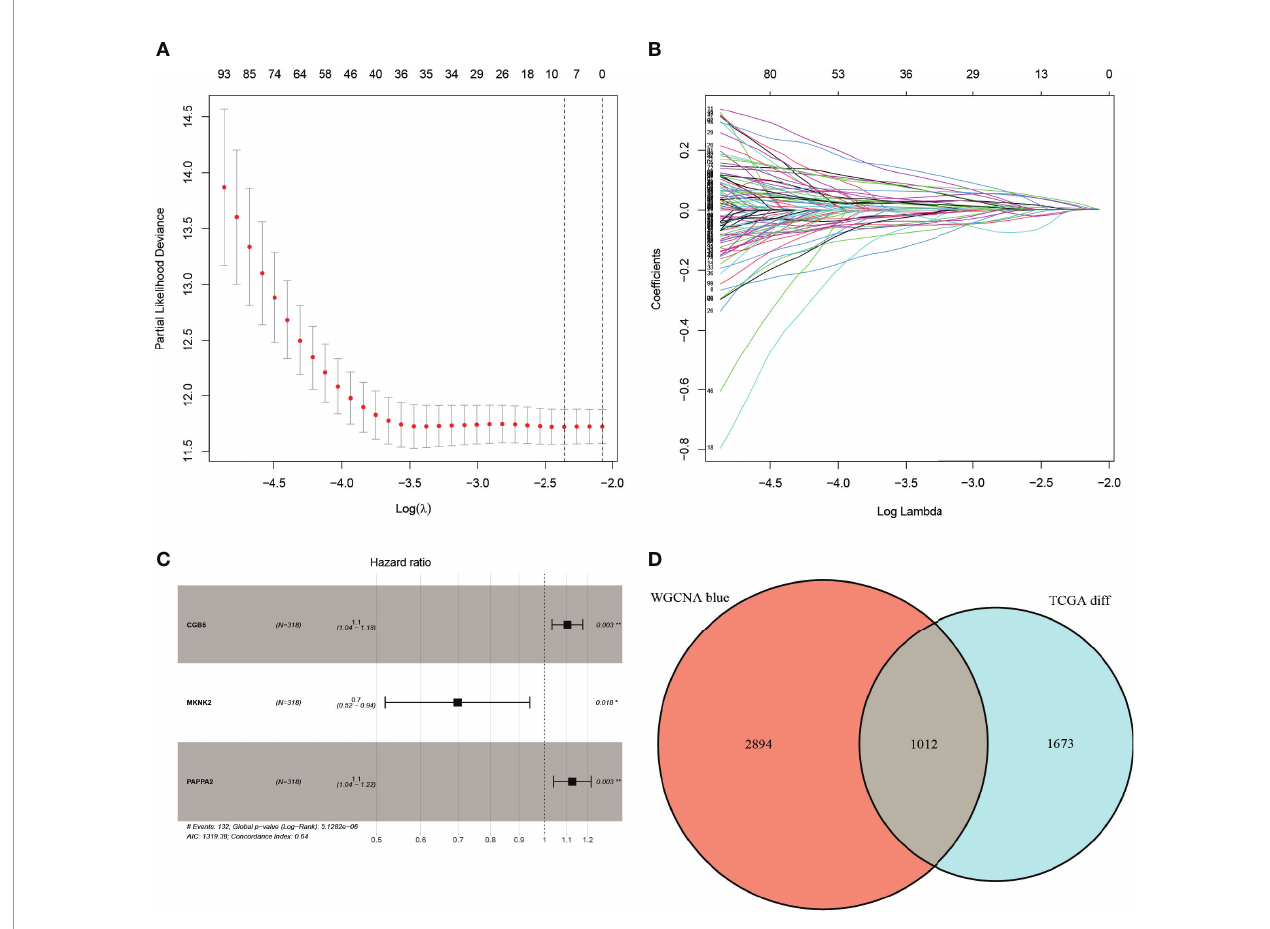
FIGURE 5 | LASSO regression analysis, multi-factor regression analysis and veen plots. Plots (A, B) represent the minimum penalty coef fi cient model constructed using the LASSO regression model. The (C) -plot represents the fi nal forest plot obtained for the three genes used to construct the model. The (D) -plot represents the Venn diagram of differentially expressed genes with the corresponding modules of